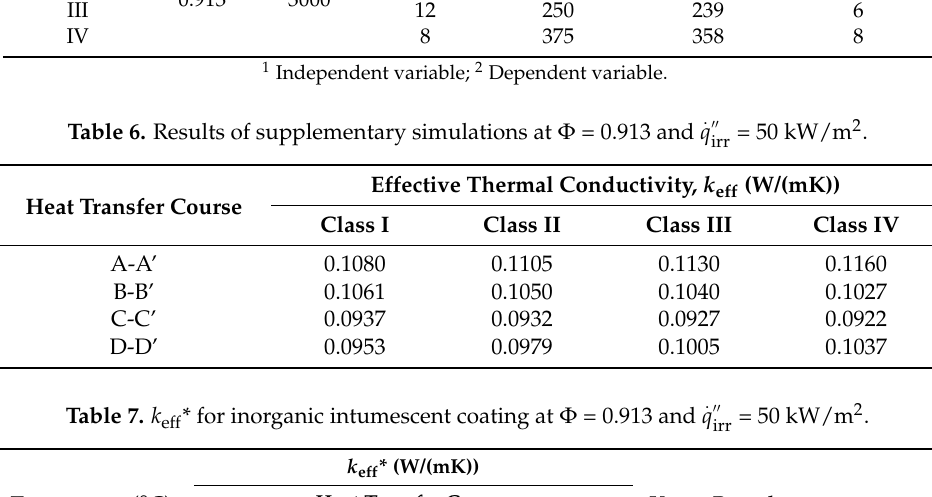
Table 5. Geometric variables used in the supplementary FEA simulations .